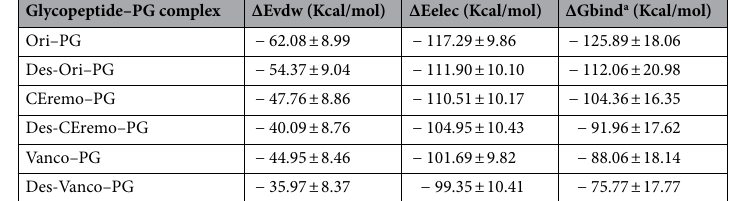
Table 2. MM/PBSA binding free energy decomposition. a MM/PBSA